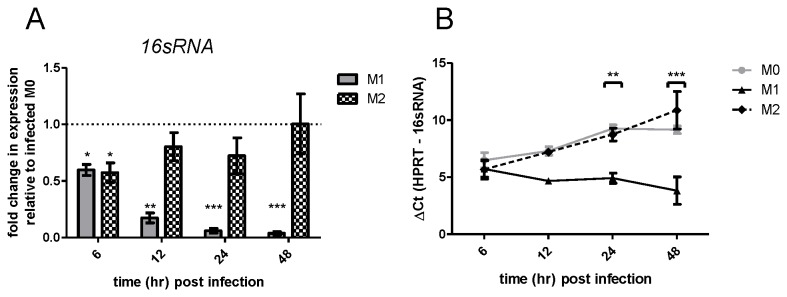
RT-PCR of Chlamydia 16sRNA demonstrates that 16sRNA remains stable in M1 macrophages, but increases in M0 and M2.Polarized BMDM infected with
Chlamydia
 were harvested at times indicated. (A) Pfaffl calculated fold change in 16sRNA in polarized macrophages (M1/M2) versus M0 demonstrates significantly lower
Chlamydia
 load in M1 macrophages at all timepoints. Treatments and timepoints analyzed separately by one-sample t-test versus hypothetical mean of 1.0 (B) Difference in ∆Ct between HPRT and 16sRNA for all samples demonstrates that decreased fold change in 16sRNA in M1 macrophages is due to increased 16sRNA expression in M0 macrophages rather than a decrease in M1. Data analyzed by repeated measures two-way ANOVA and Bonferroni’s post test. All data is mean ±SEM of three separate experiments.